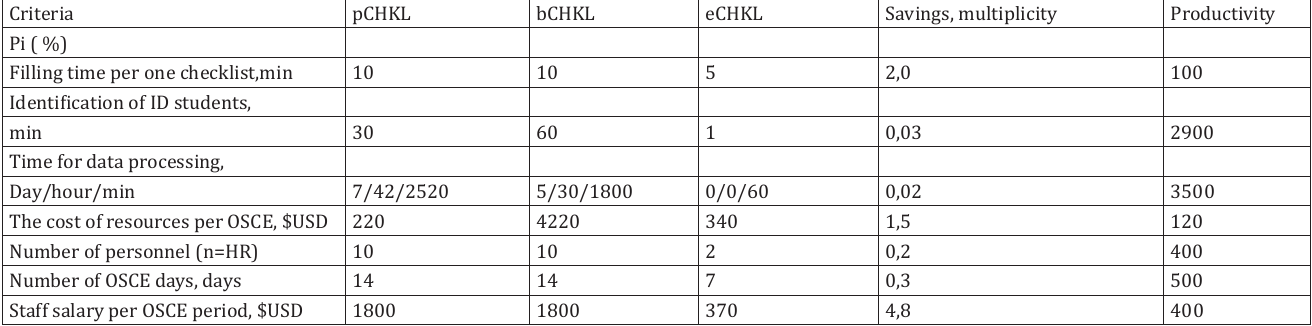
Comparative table of the evaluation sheet in pCHKL, bCHKL, and eCHKL in OSCE with the calculation of savings Table 1 due to the increase in staff productivity. http://www.antegra.ru/news/experts/_det-experts/4/